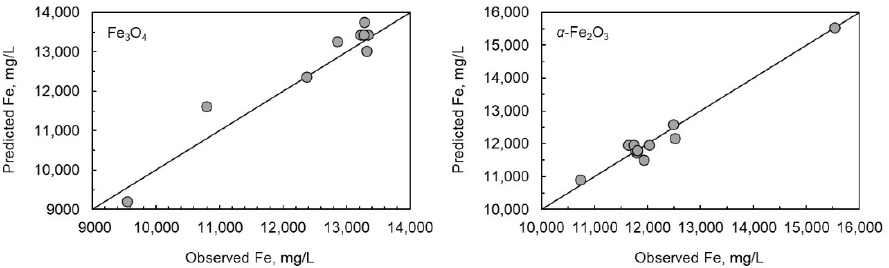
Figure 4. Scatter plots of measured and modelled Fe concentration for magnetite and hematite dissolved in different oxalic and nitric acid systems.